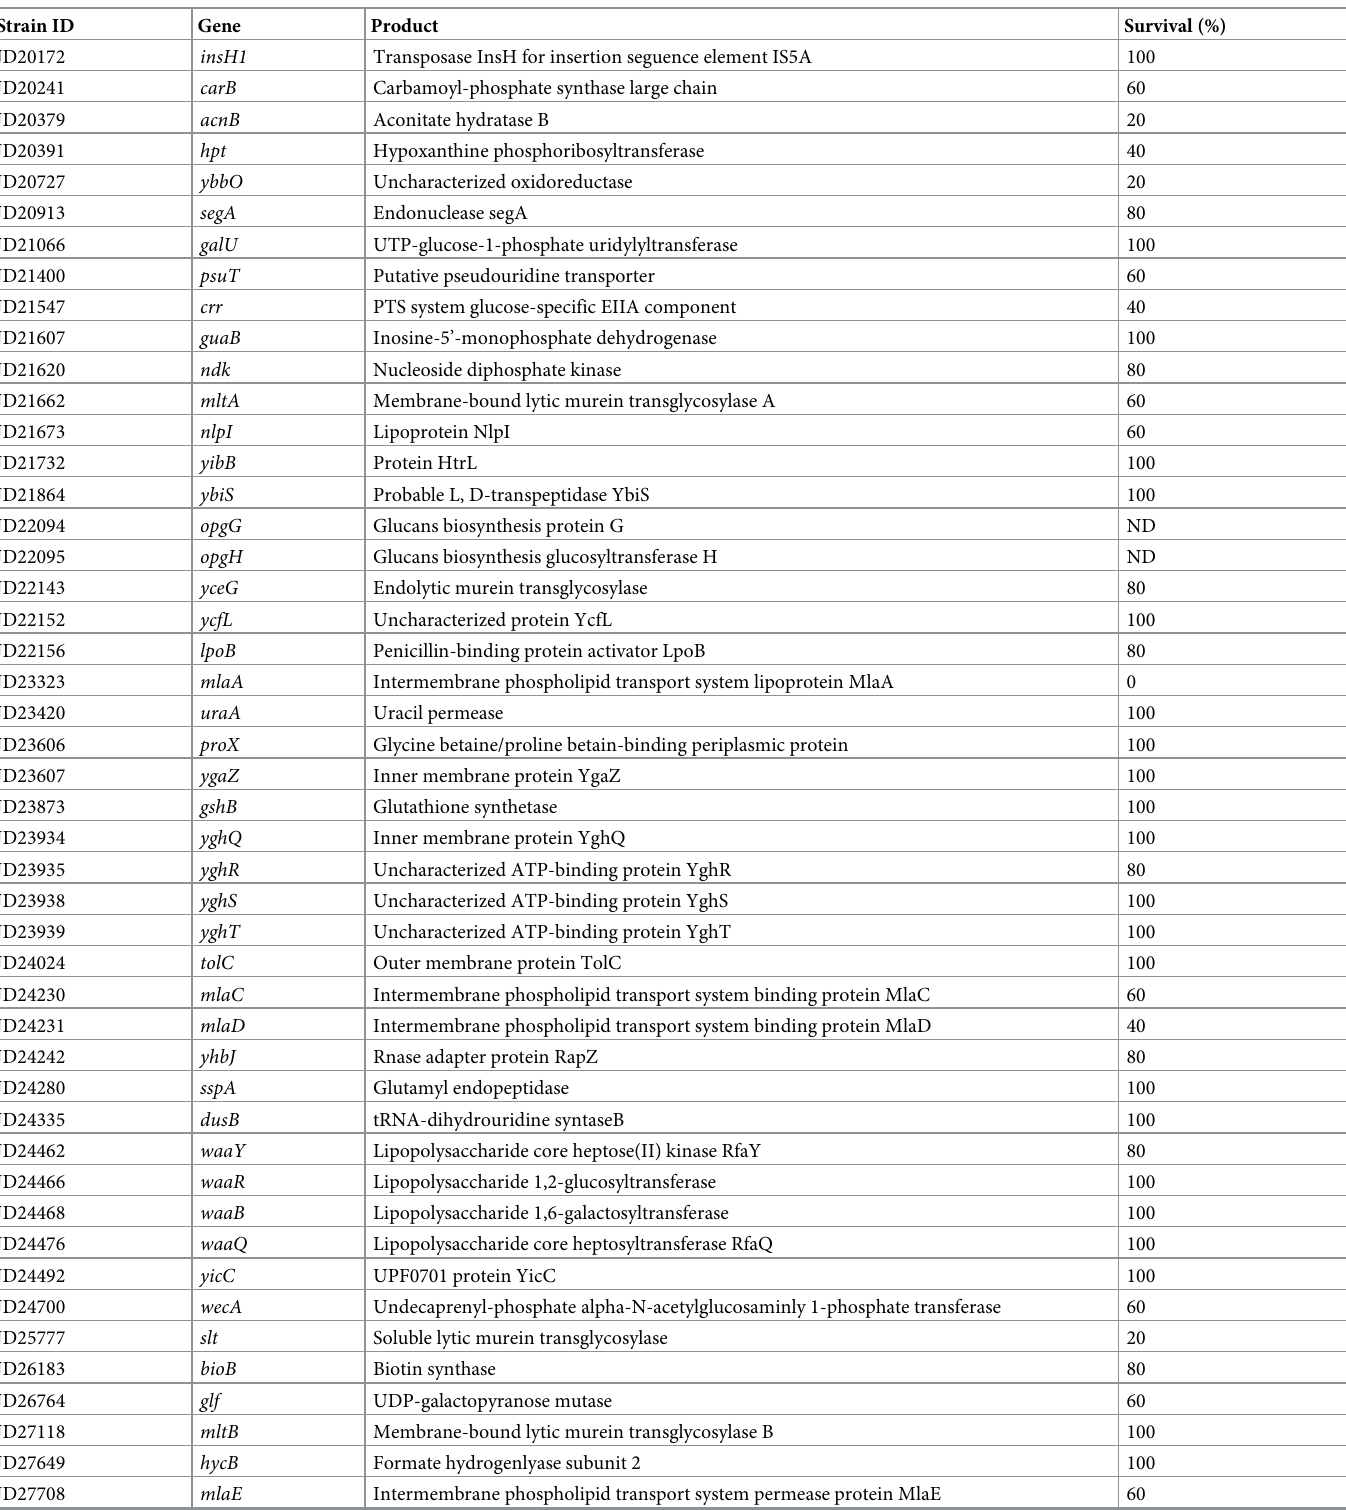
Table 1. Silkworm-killing activities of transposon mutants exhibiting resistance against